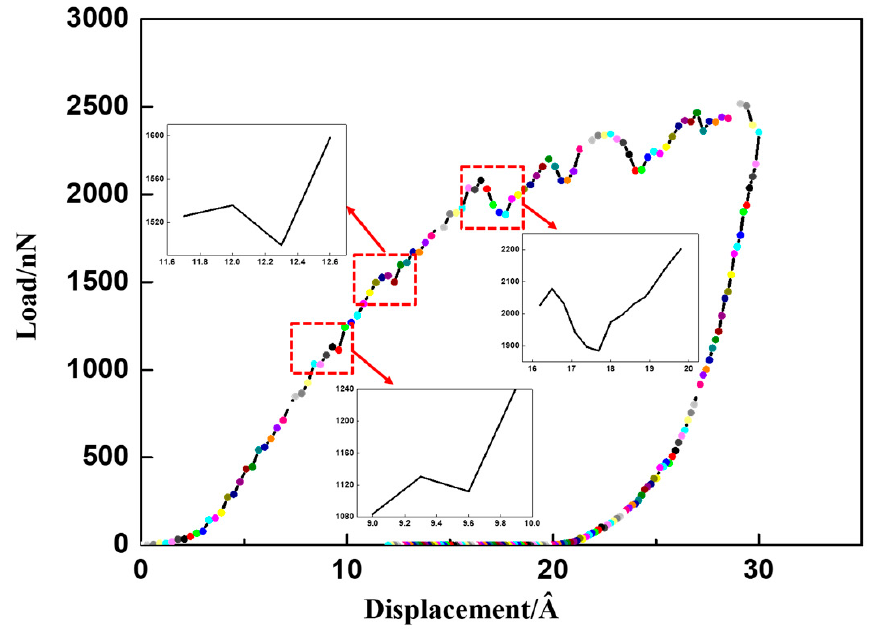
Figure 5. The evolution of the indentation force with the indentation depth during indentation at the loading-unloading rate of 2 Å/ps.